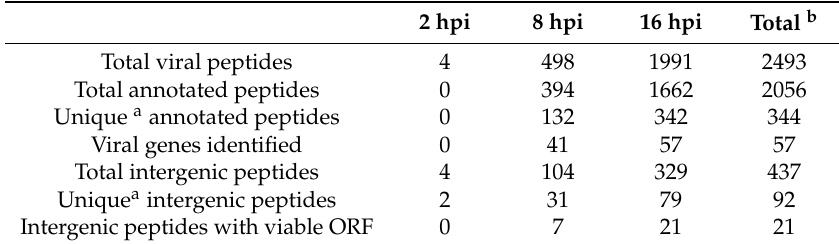
Table 2. Summary of proteogenomic mapping results.